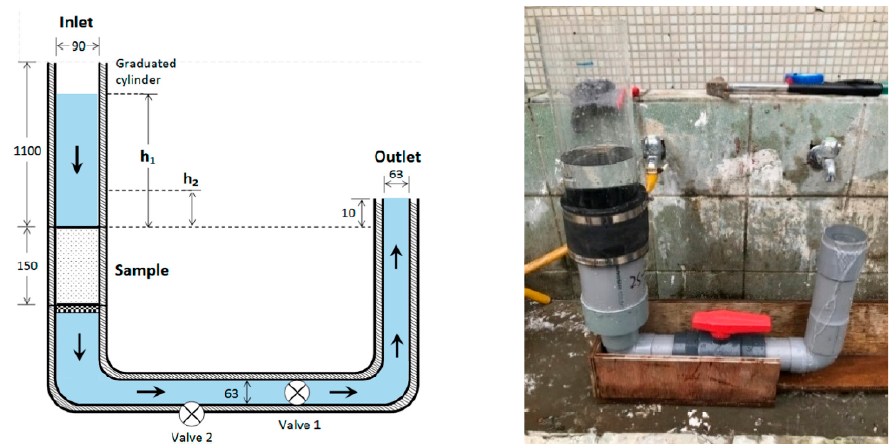
Figure 1. Water permeability coefficient instrument and cross-section diagram.